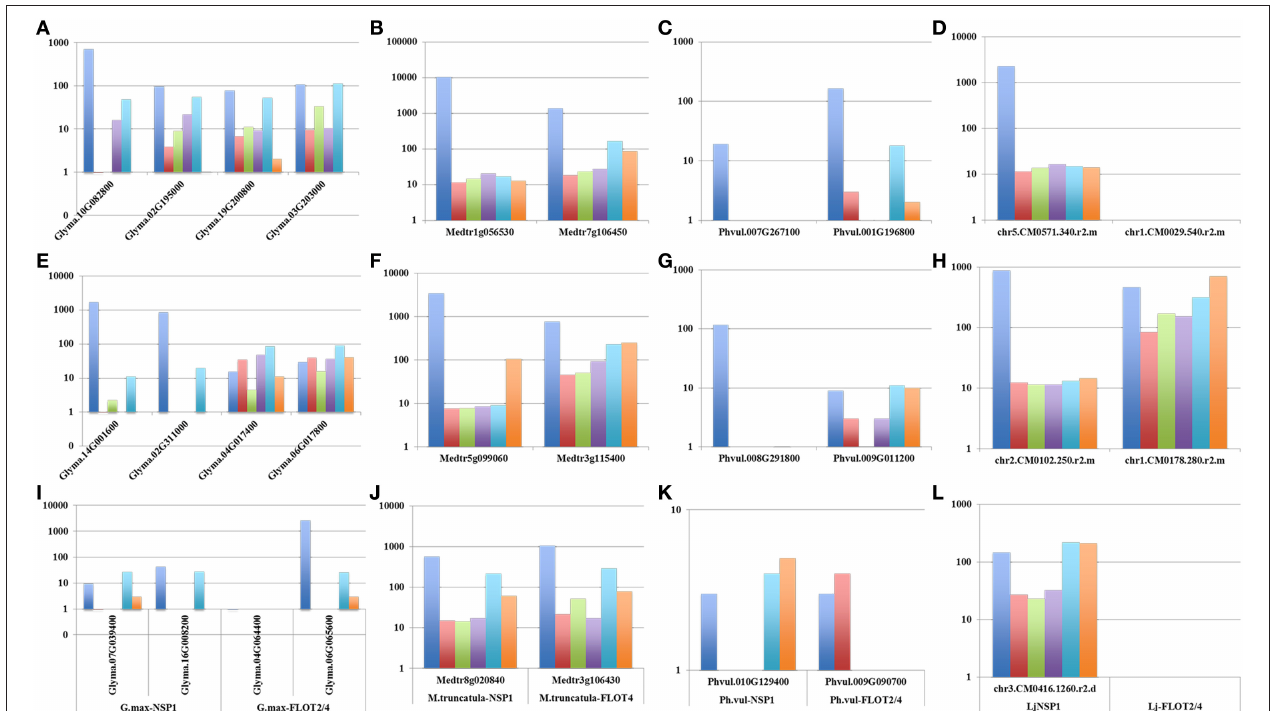
FIGURE 3 | Relative expression levels of NF-YA1/2 (A–D) , NIN (E–H) , NSP1 and FLOT2/4 (I–L) of M. truncatula genes (B, F, J), and their G. max orthologs (A, E, I), P. vulgaris orthologs (C, G, K) and L. japonicus (D, H, L) in various plant organs (i.e., blue, nodule; orange, flower; gray, pod; yellow, leaf; dark blue, root; and green, root tip). Gene IDs are highlighted on the x-axis. The relative expression levels of the genes (log10 scale) are indicated on the y-axis. Gene expression datasets were mined from the G. max, M. truncatula, P. vulgaris, and L. japonicus atlases datasets (Benedito et al., 2008; Libault et al., 2010c (http://mtgea.noble.org/v3/); Verdier et al., 2013; O’Rourke et al.,